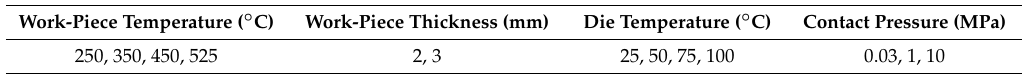
Figure 3. Temperature profile of work-piece during in-die quenching process: ( a ) HFQ ® technology for lower temperatures (solid line) and alternative process (dash line); and ( b ) conventional forming using HFQ ® technology. Table 2. Test matrix of in-die quenching efficiency